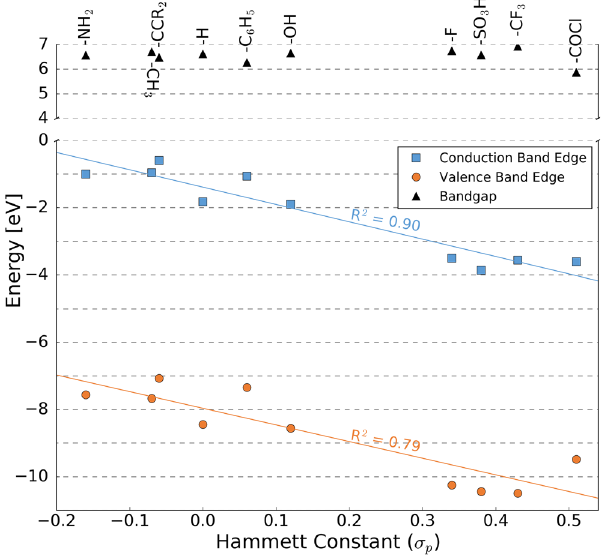
Figure 4. Linear relationships between band gap, electron affinity, and ionization potential and the Hammett constant of the functional group R .